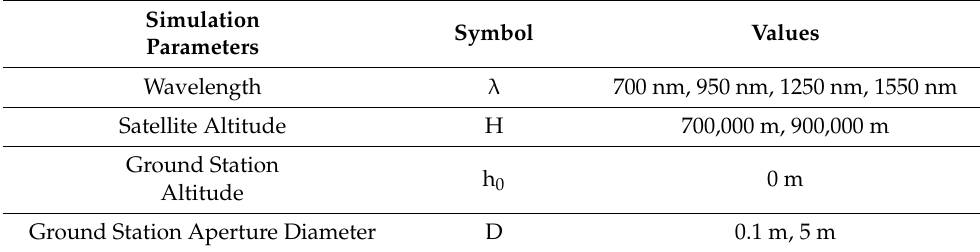
Table 1. Simulation parameters used for the uplink and downlink FSO channels.